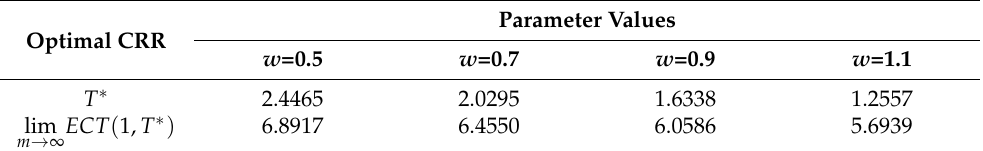
Table 3. The impacts of w on the optimal CRR.